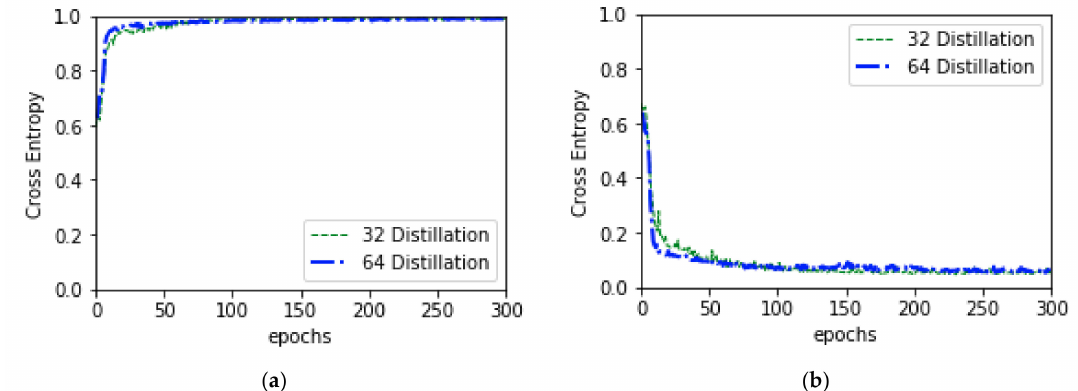
Figure 8. Combine validation accuracy and validation loss of knowledge distillation training: ( a ) depicts combine validation accuracy and ( b ) depicts combine validation loss.